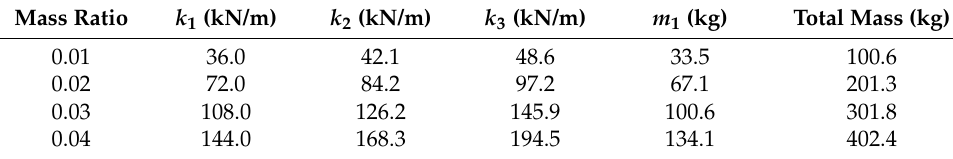
Table 5. Design parameters of MTMD under different total mass